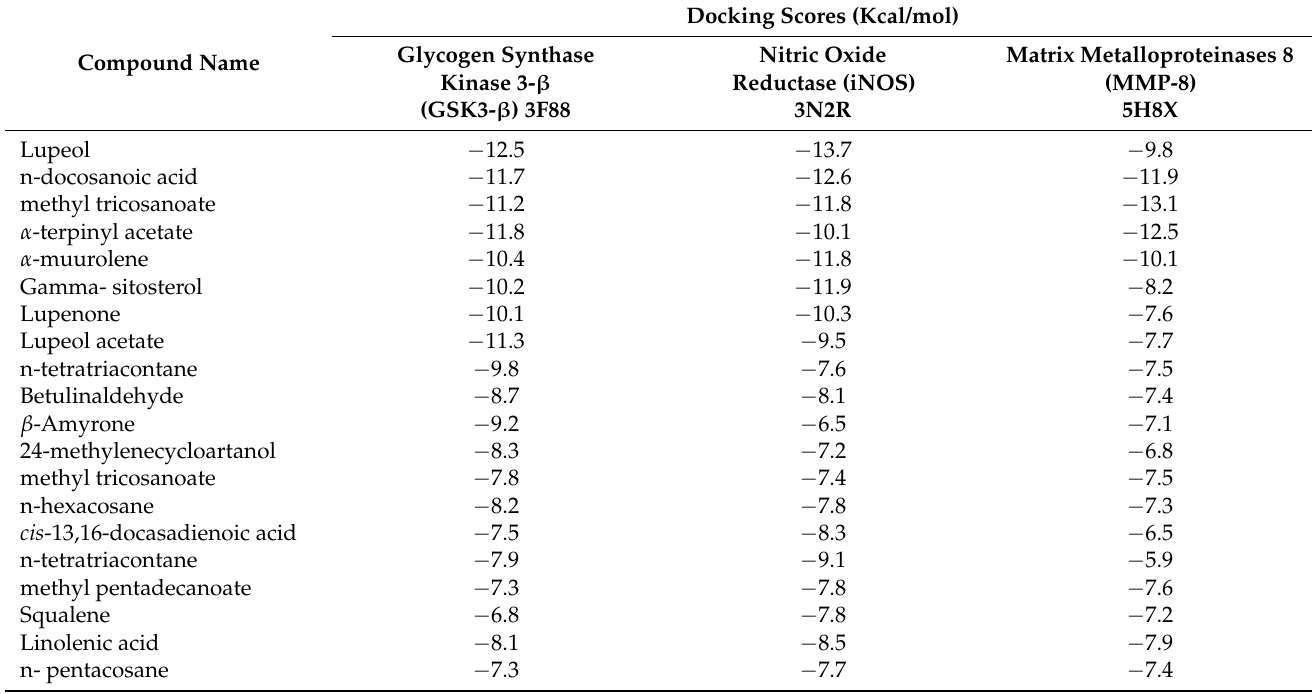
Table 4. The docking scores achieved by the major identified compounds against the three